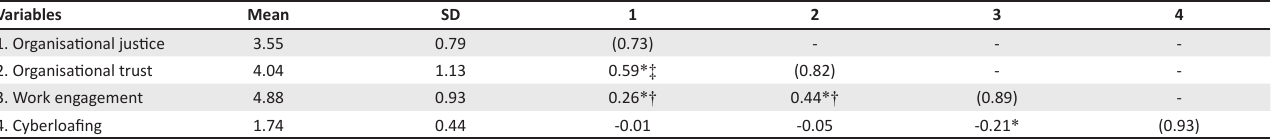
TABLE 3: Reliabilities and correlation matrix for the latent variables. Variables